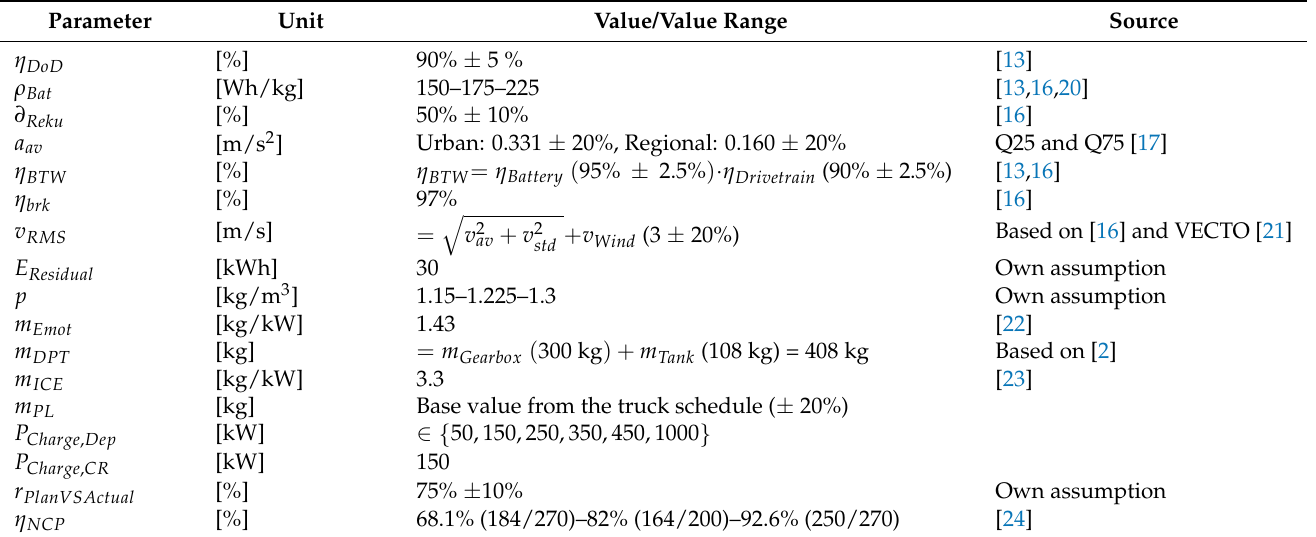
Table 2. Other simulation parameters. Ranges indicate the PERT distribution’s minimum, most likely, and maximum values. Individual parameters are constant